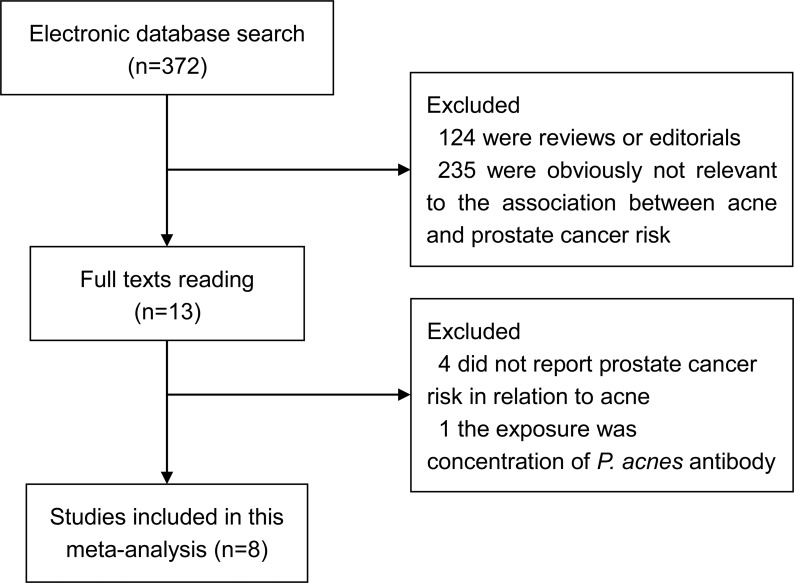
Literature search and selection process.